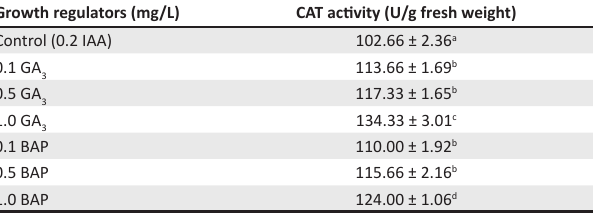
TABLE 6: Effect of different concentrations of gibberellic acid and benzyl aminopurine in combination with indole acetic acid in Murashige and Skoog medium on catalase activity in O. gratissimum explants after 28 days of culture. Growth regulators